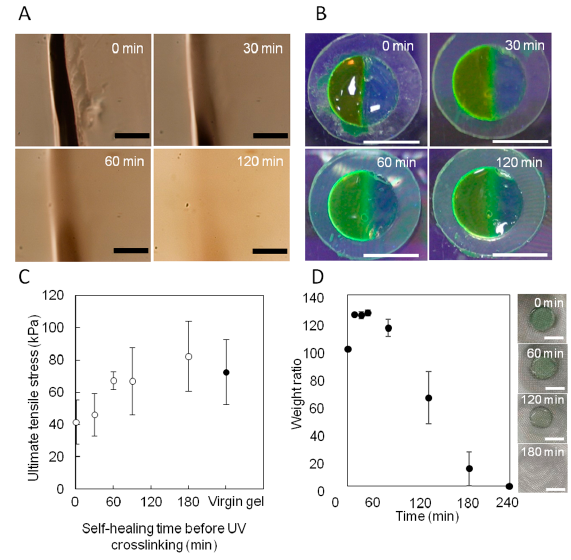
Figure 2. ( A ) Microscopic observation of the fluidic behavior of SHT (scale bar = 200 μ m). Time-lapse ( A ) Microscopic observation of the fluidic behavior of SHT (scale bar = 200 µ